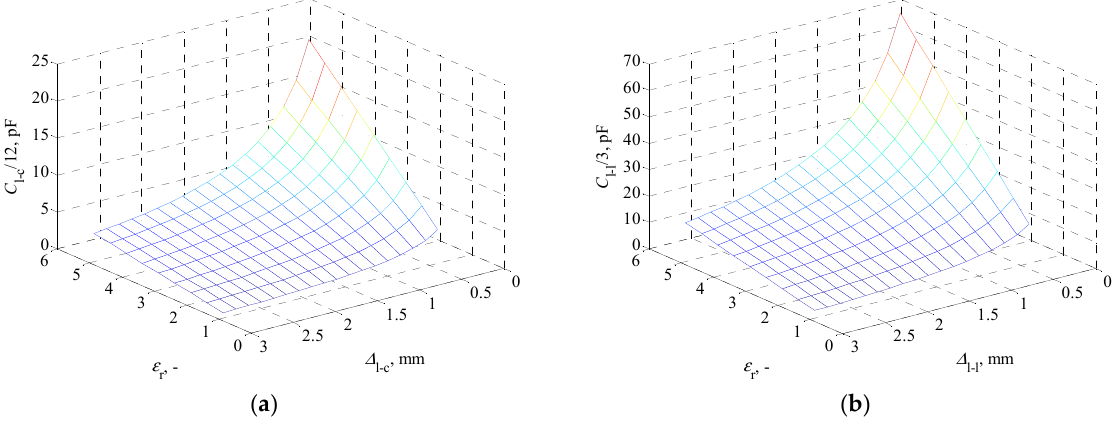
Figure 4. ( a ) Dependence of material permittivity ( ε r ) and distance between core and first layer Δ l-c and ( b ) two layers Δ l-l on parasitic capacitance of designed inductors.